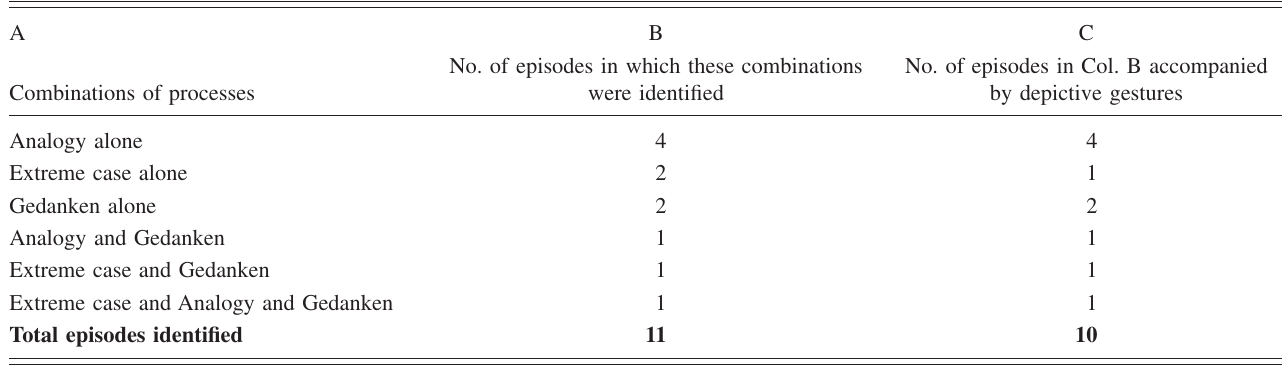
TABLE II. Evidence for student-generation of three nonformal scientific reasoning processes in Gravity discussion (cid:1) 42 min (cid:2) : Numbers of